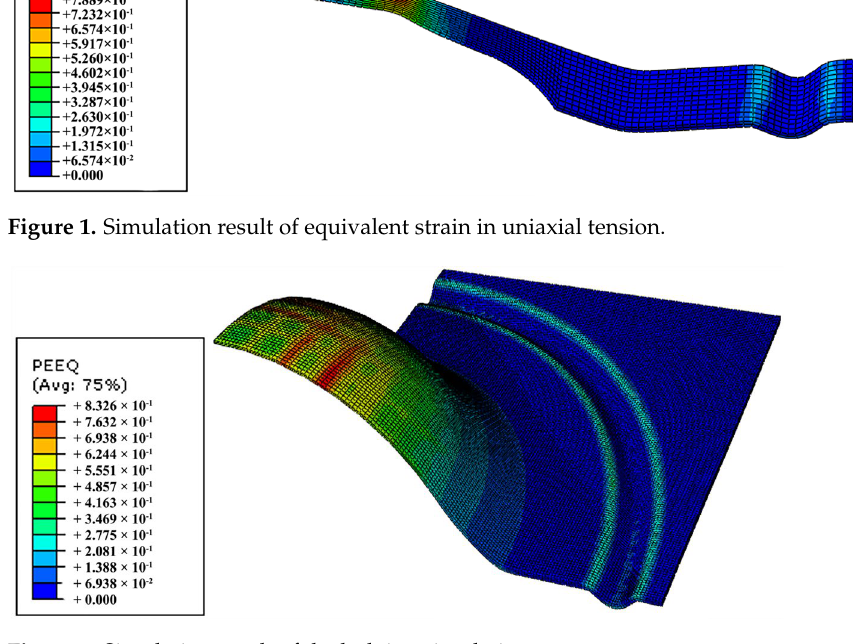
Figure 2. Simulation result of the bulging simulation.